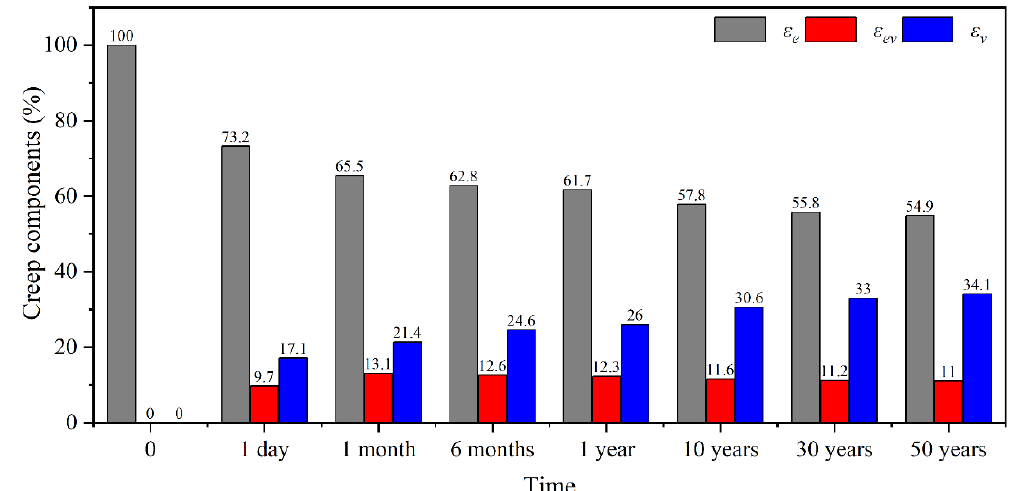
Figure 11. The change laws of creep components.